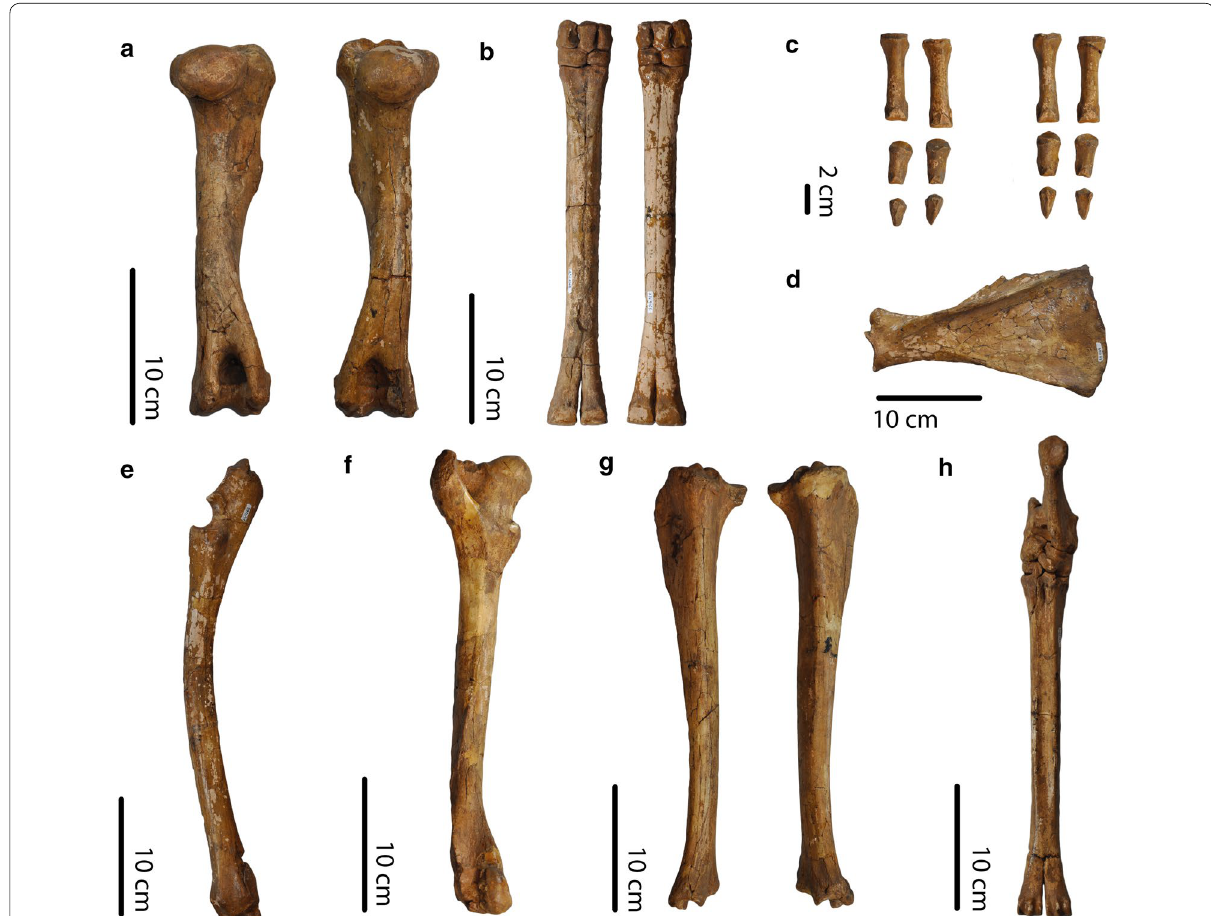
Fig. 11 PIMUZ A/V 4165. a Left and right humeri, dorsal view. b Left and right metacarpals and carpals, ventral view. c Phalanges, ventral view. d Left scapula, lateral view. e Left radio‑ulna, lateral view. f Left femur, dorsal view. g Right and left tibiae , dorsal view. h Right metatarsal and tarsals, dorsal